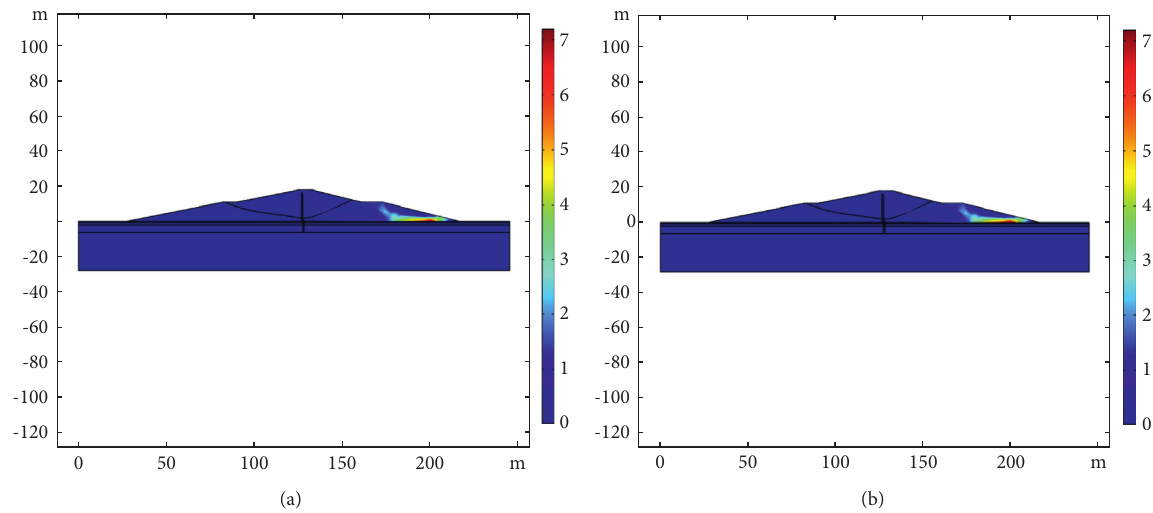
Figure 11: The effective plastic strain before the cofferdam failure under (a) flood level and (b) low water level.